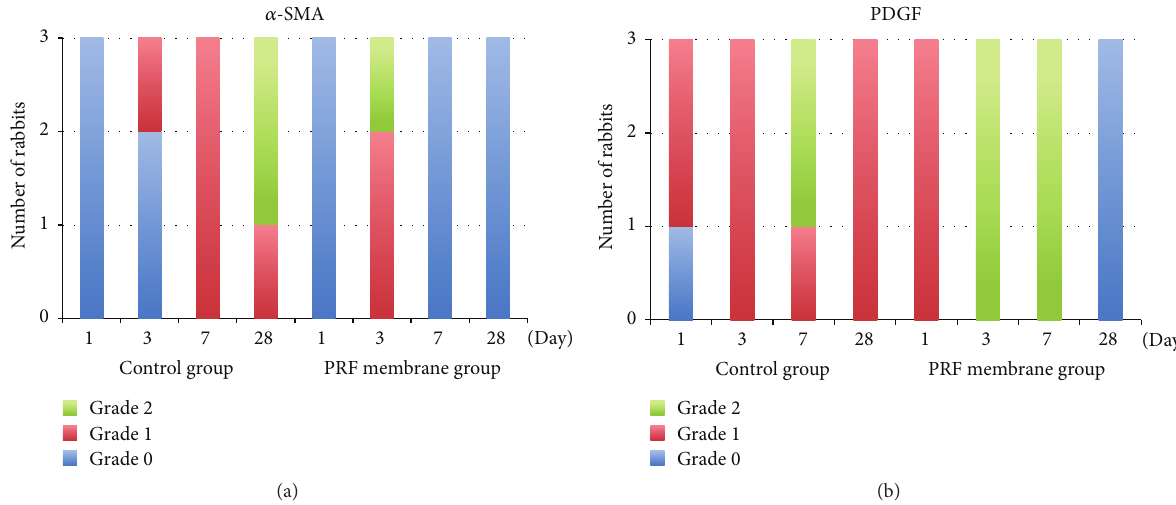
Figure 6: Comparison of the staining intensity of 𝛼 -SMA and PDGF. (a) Histogram of the 𝛼 -SMA staining. (b) Histogram of the PDGF